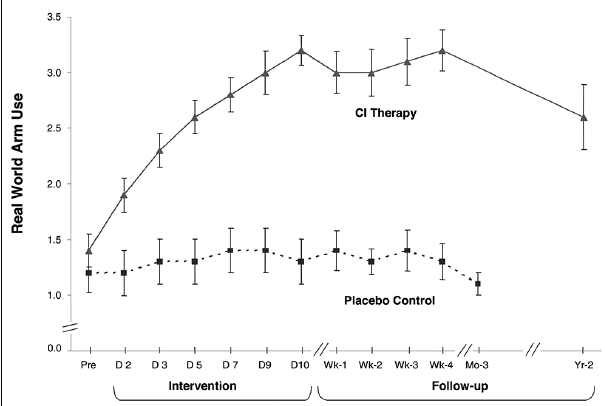
FIGURE 1 | Mean MAL arm use scores from CI therapy ( n = 21) and placebo control ( n = 20) patients with chronic stroke. CI therapy subjects showed a very large improvement in arm use outside the laboratory from pretreatment to post-treatment (1.8 ± 0.6; P < 0.0001; d’ = 3.0). Before treatment the data indicate that these patients were using the more affected arm 14% as much as before stroke, while after 2 weeks of treatment it was 52%, an almost four times increase. Controls showed little change. CI therapy subjects retained all of their immediate treatment gains 4 weeks after therapy and showed only a 23% decrease after 2 years from post-treatment levels of real-world arm use. At 1-year post-treatment the loss in retention was 14%. Reprinted fromTaub etal.